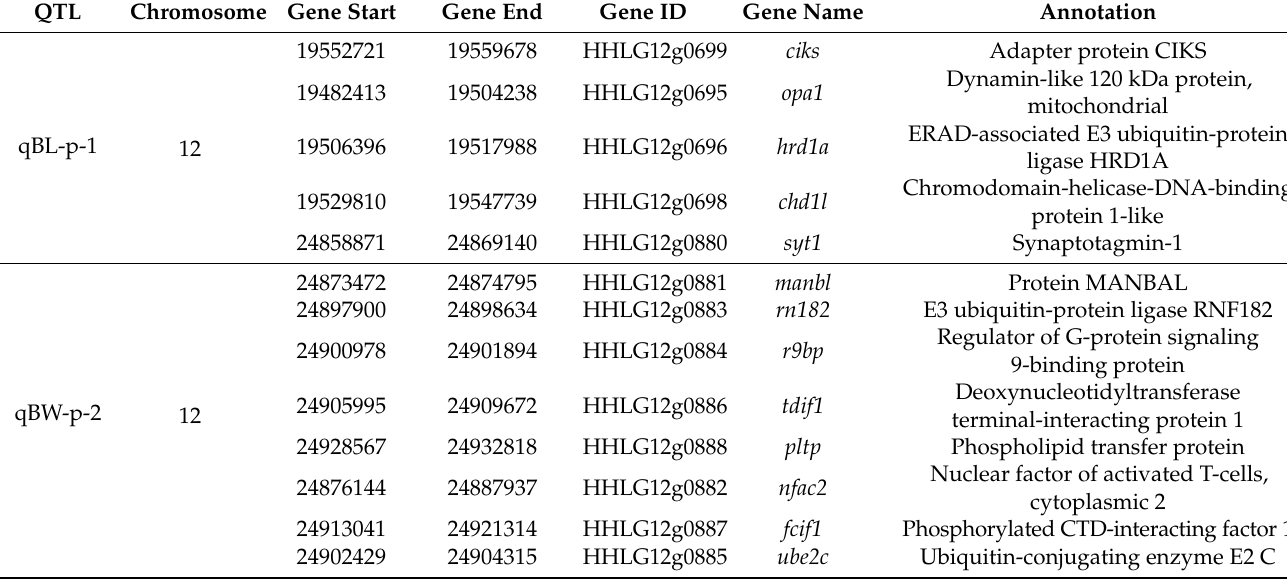
Table 7. Candidate genes related to main-effect QTL in Yellow River carp at 5–17 months after